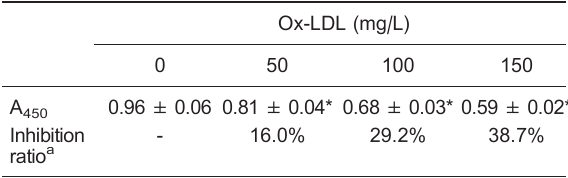
Table 1. Anti-proliferation effect of Ox-LDL in human umbilical vein endothelial